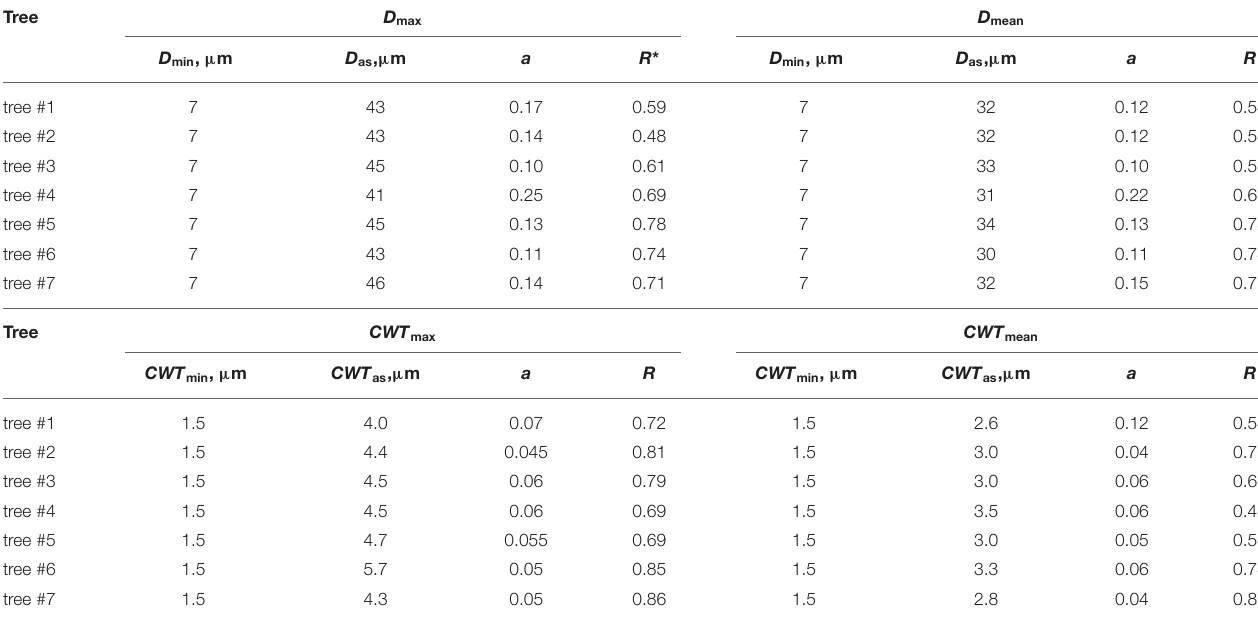
TABLE 1 | Numerical parameters of the dependencies of tracheid measurements (cell radial diameter D and cell wall thickness CWT ) on cell number N , expressed as functions D = D min + ( D as − D min ) · (cid:0) 1 − e − a · N (cid:1) , CWT = CWT min + (cid:0) CWT as − CWT min (cid:1) · (cid:0) 1 − e − a · N (cid:1) fitted for maximal ( D max , CWT max ) and mean ( D mean , CWT mean ) values in the